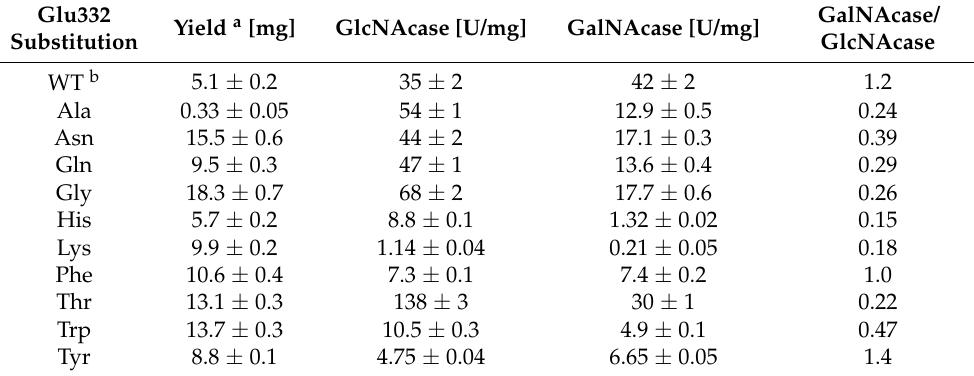
Table 1. Purification yields and specific activities of site-directed mutants of Tf